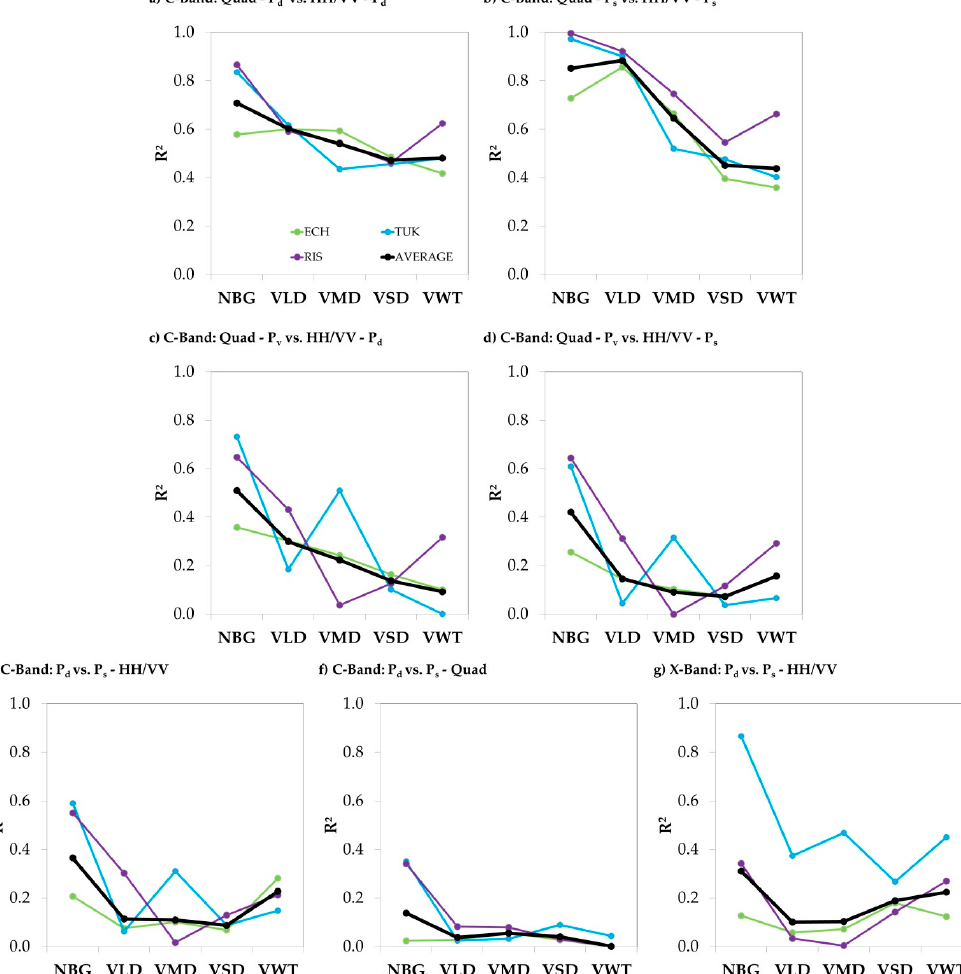
Figure 3. Squared linear Pearson correlation coefficients (R 2 ) for none-water land cover classes (NBG, VLD, VMD, VSD, VWT) of: ( a ) double bounce (P d ) of the two and three component decomposition;